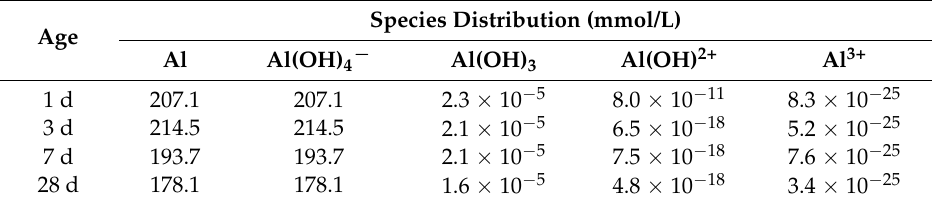
Table 6. Species distribution of aluminum in CSA pore solution simulated by